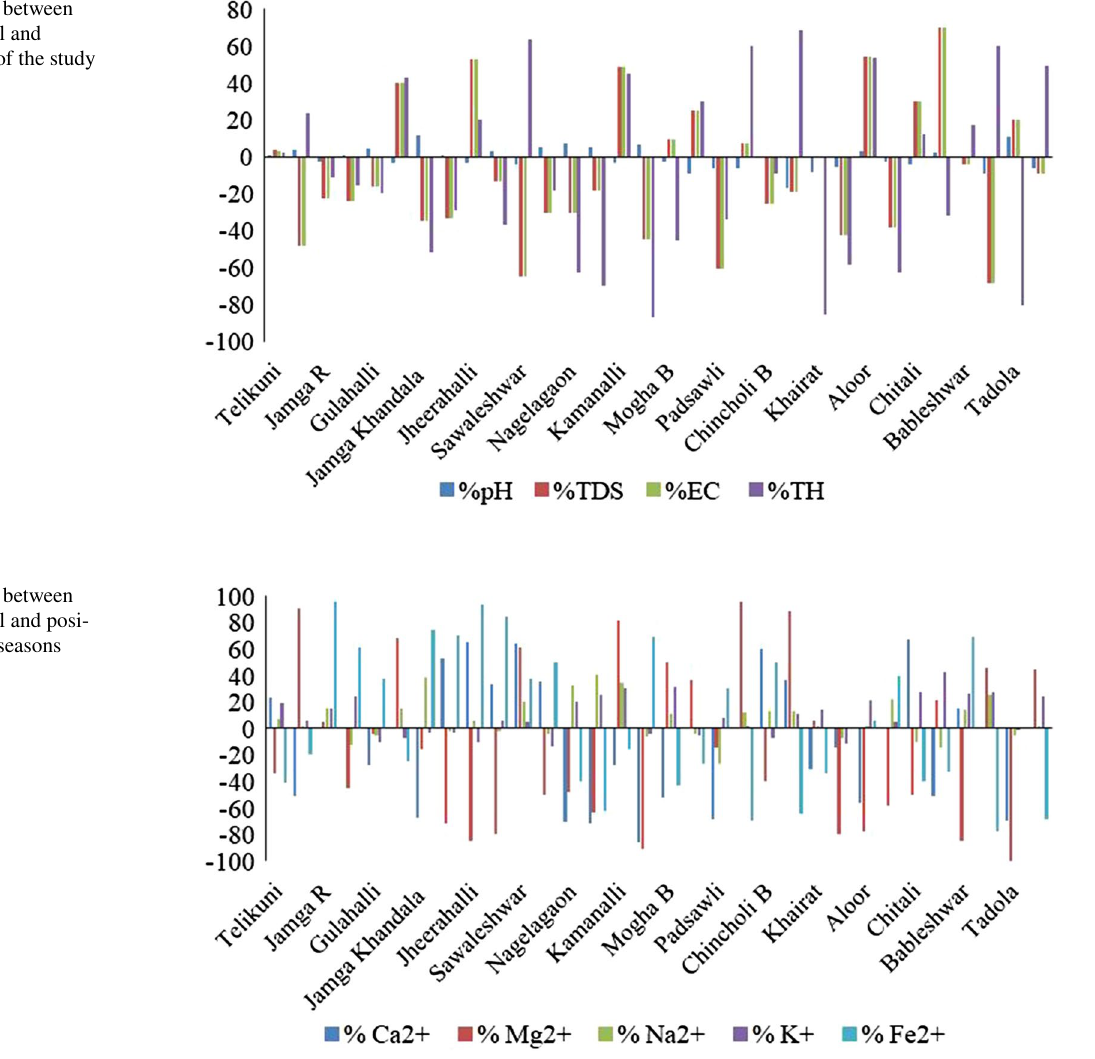
Fig. 41 Relationship between the maximum rainfall and physical parameters of the study area